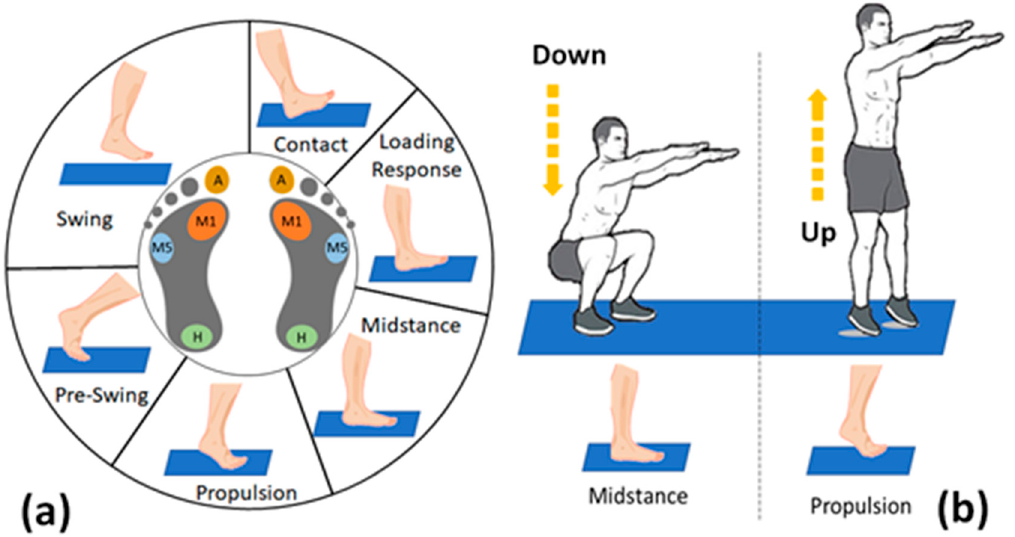
Figure 3. Footswitches involved during the exercises: ( a ) gait phase; ( b ) squat phase. Table 3. Muscles involved by the specific gait phase.